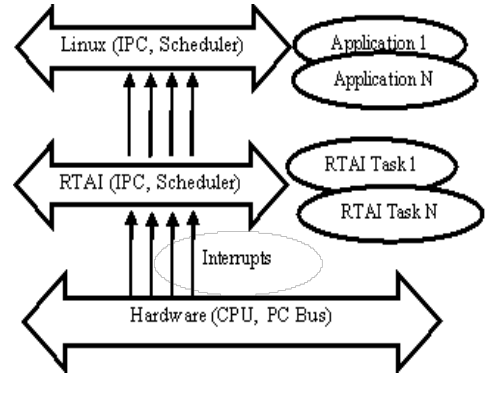
Figure 2. RTAI architecture (Adapted from